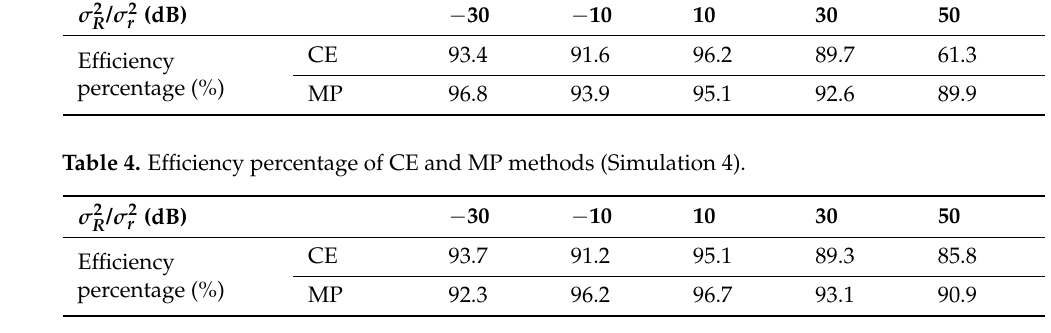
Simulation 5: Minimum number of